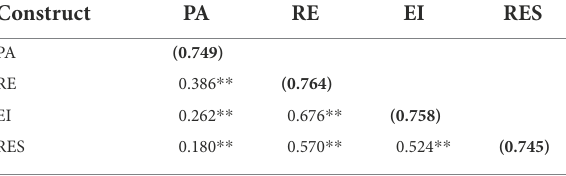
TABLE 2 Discriminant validity test. TABLE 3 Participant profile ( N = 402).